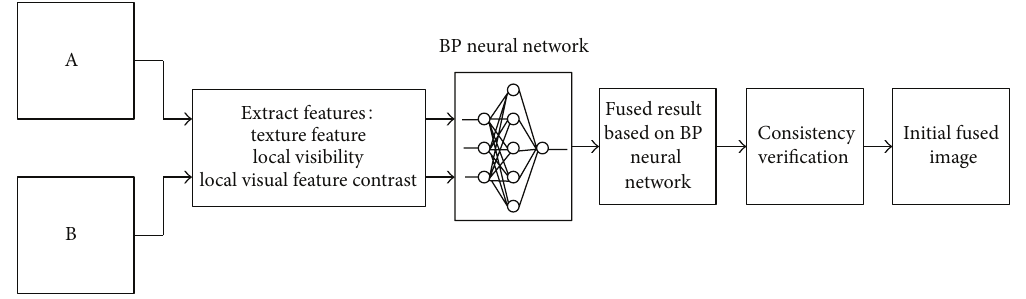
Figure 2: Schematic diagram of the BP neural network based fusion method.